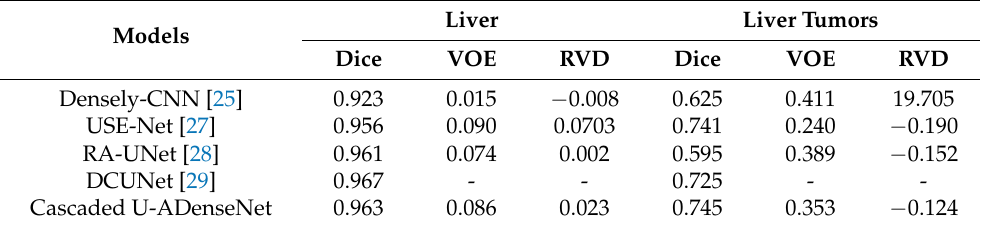
Table 3. Segmentation performance and comparison of various